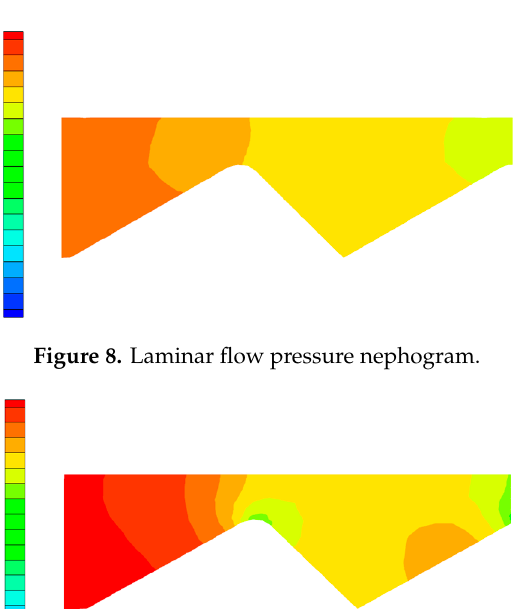
Figure 7. Turbulent flow vectorgraph.